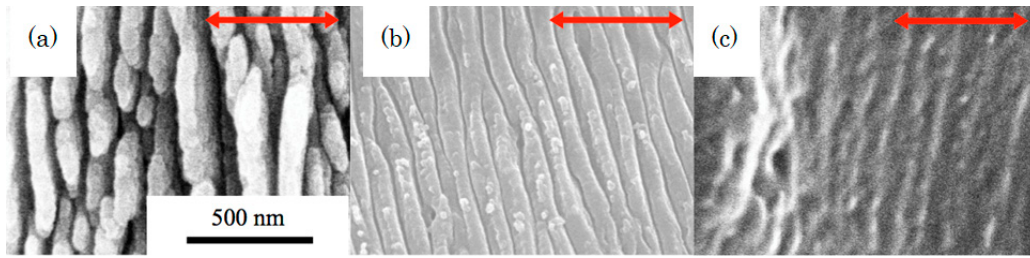
Figure 5. LIPSS formed on the PLLA surface by the irradiation of femtosecond laser pulses at different wavelengths. ( a ) 800 nm, 1.0 J/cm 2 , 3000 pulses; ( b ) 400 nm, 0.4 J/cm 2 , 5000 pulses; ( c ) 266 nm, 7.5 mJ/cm 2 , 5000 pulses. Red double-headed arrows indicate the polarization direction.